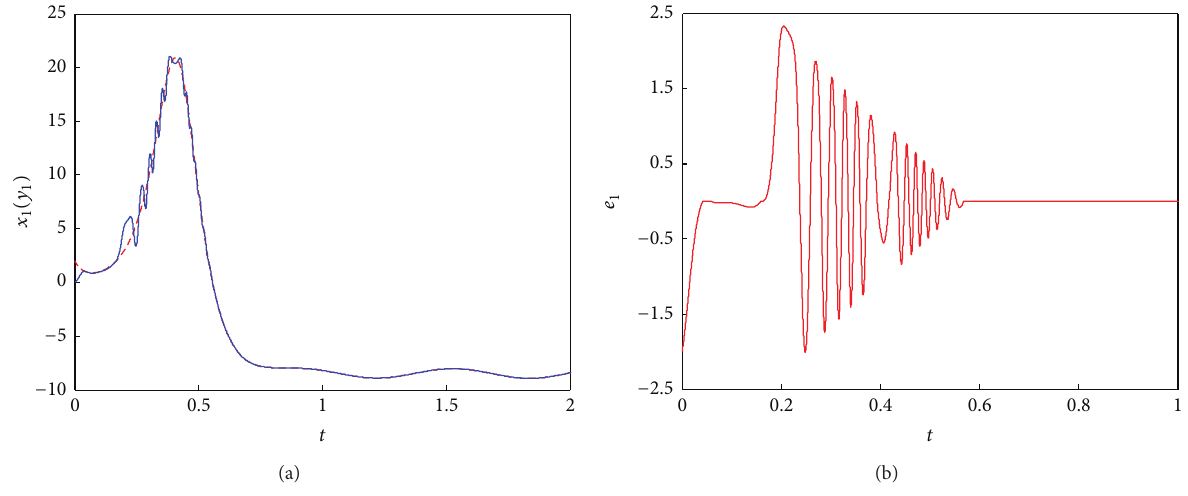
Figure 1: Time series and synchronization error of trajectories of the Lorenz system and the L¨u system: (a) 𝑥 1 (𝑦 1 ) versus 𝑡 ; (b) 𝑒 1 versus 𝑡 .